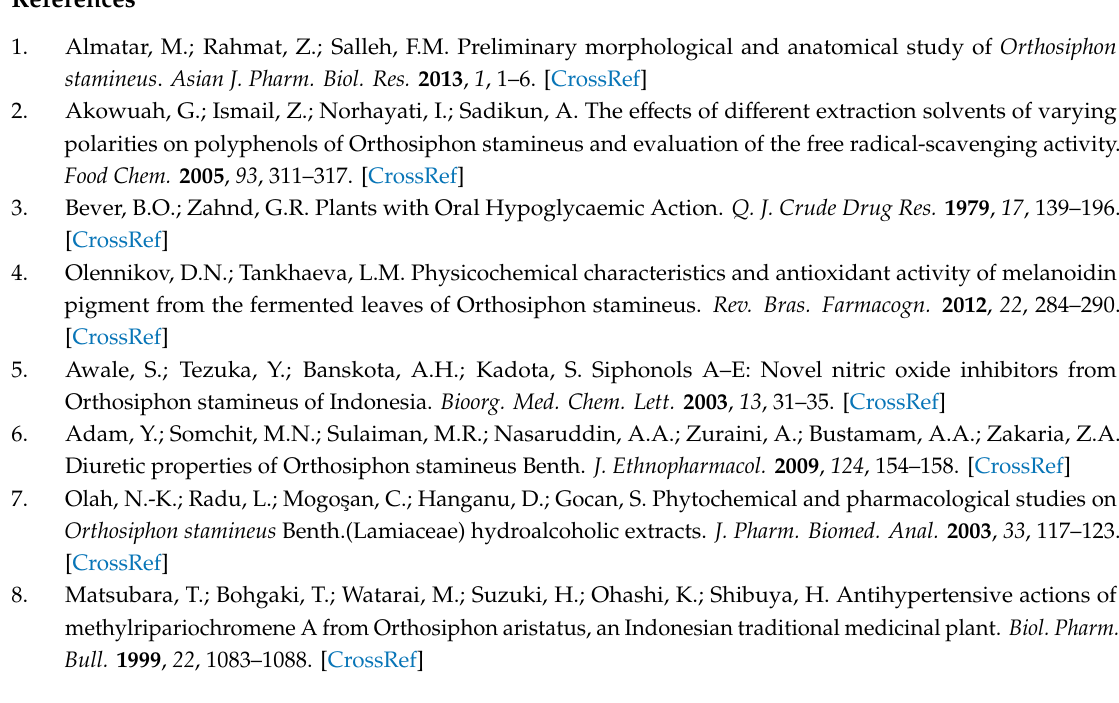
Table S1: List of primers used in the analysis